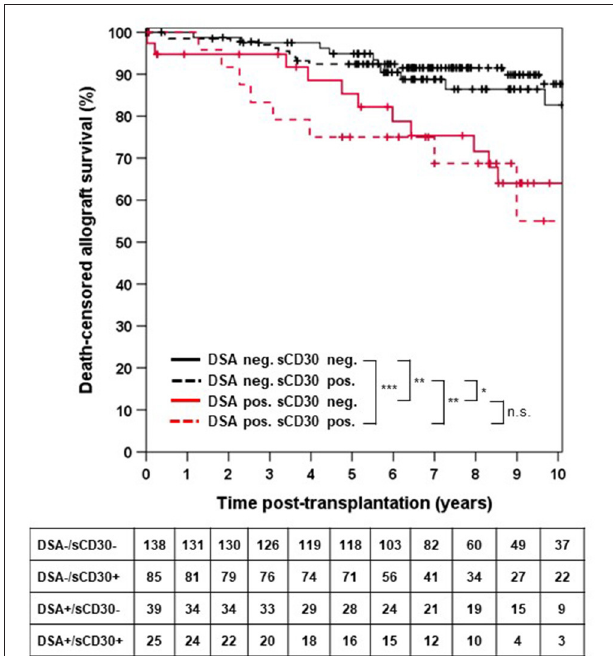
FIGURE 1 | Death-censored allograft survival stratified by DSA and sCD30 status prior to transplantation. *** p < 0.001, ** p = 0.001, * p = 0.014, and n.s. = non-significant.